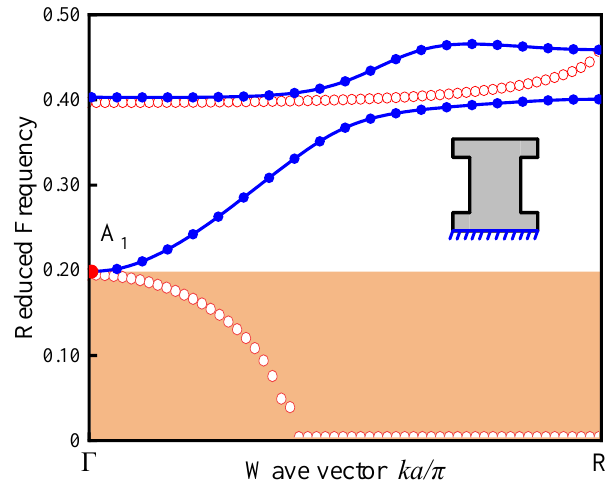
Figure 2. Dispersion relationship curve of the quasi-static REMs.